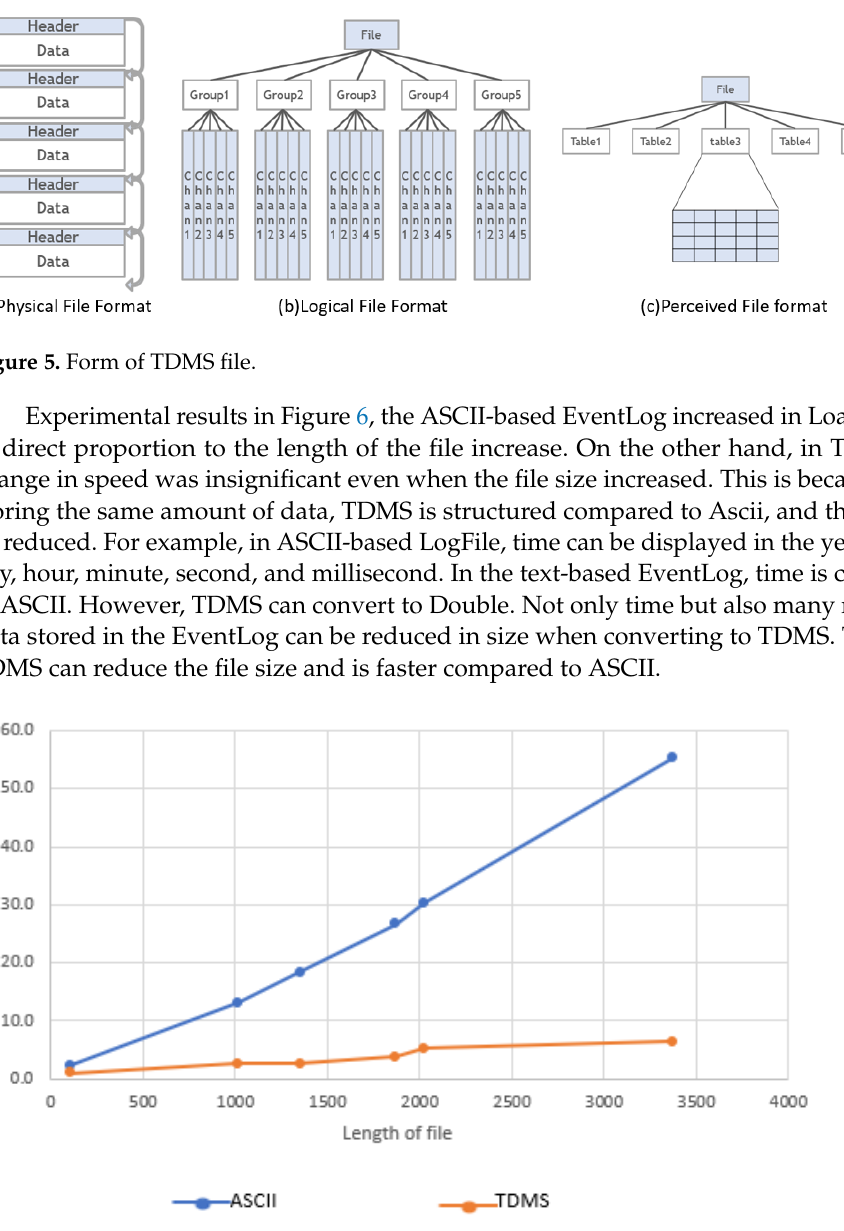
Figure 6. ASCII vs. TDMS Loading Speed